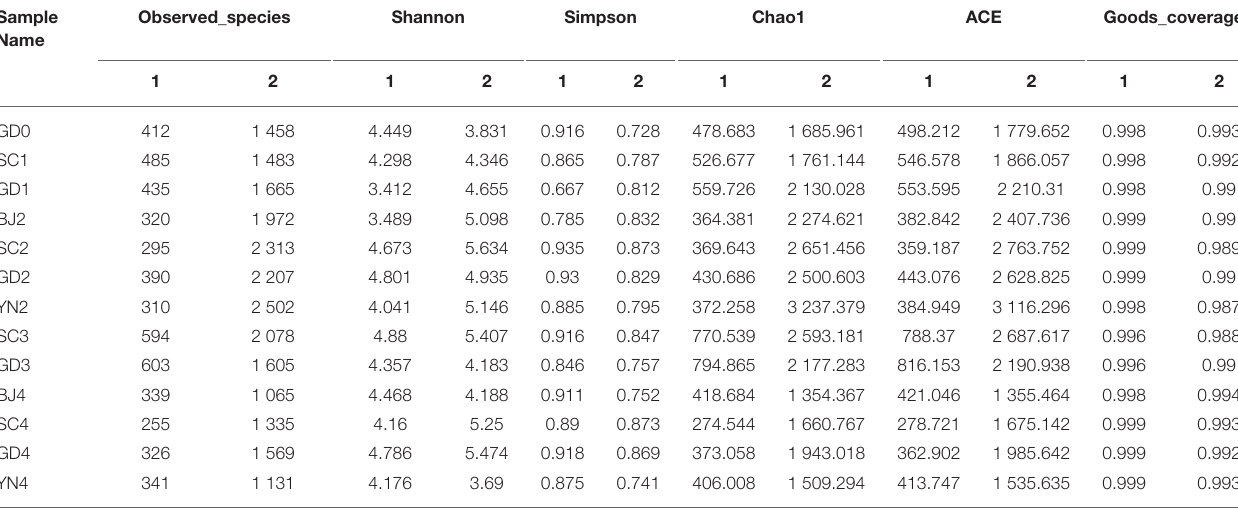
TABLE 2 | Diversity index of the microbial community in Citrus reticulata “Chachi”